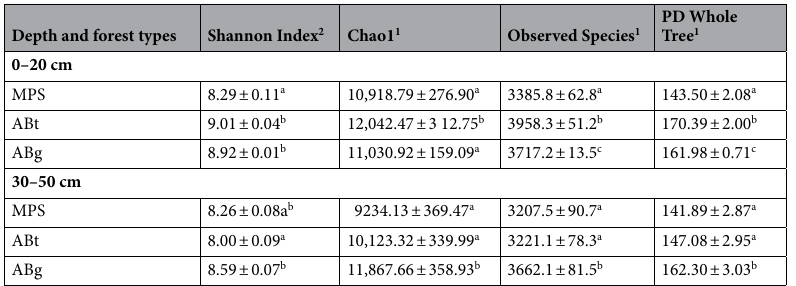
Table 2. The alpha-diversity indices of prokaryotic microbiota in the different peat swamp forest types based on soil depth. Values are mean ± standard error. Rarefied samples (22,738 sequences) were used for the analyses. Different letters in the same column indicate significant difference at the level of P < 0.05 based on Tukey’s HSD test ( 1 ) or pairwise Wilcox test ( 2